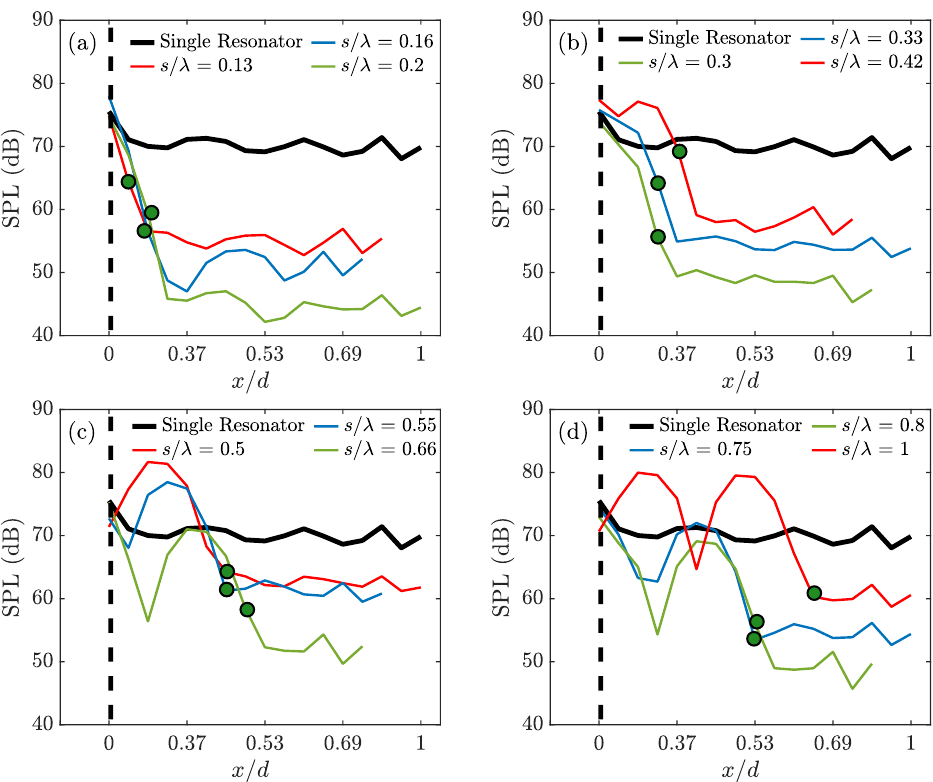
Figure 7. Change in the SPL value at resonance frequency ( f o ) in the impedance tube for different spacing configurations between 0.13 < s / λ < 1. ( a ) s / λ = 0.13 − 0.2, ( b ) s / λ = 0.3 − 0.42, ( c ) s / λ = 0.5 − 0.66, ( d ) s / λ = 0.75 −